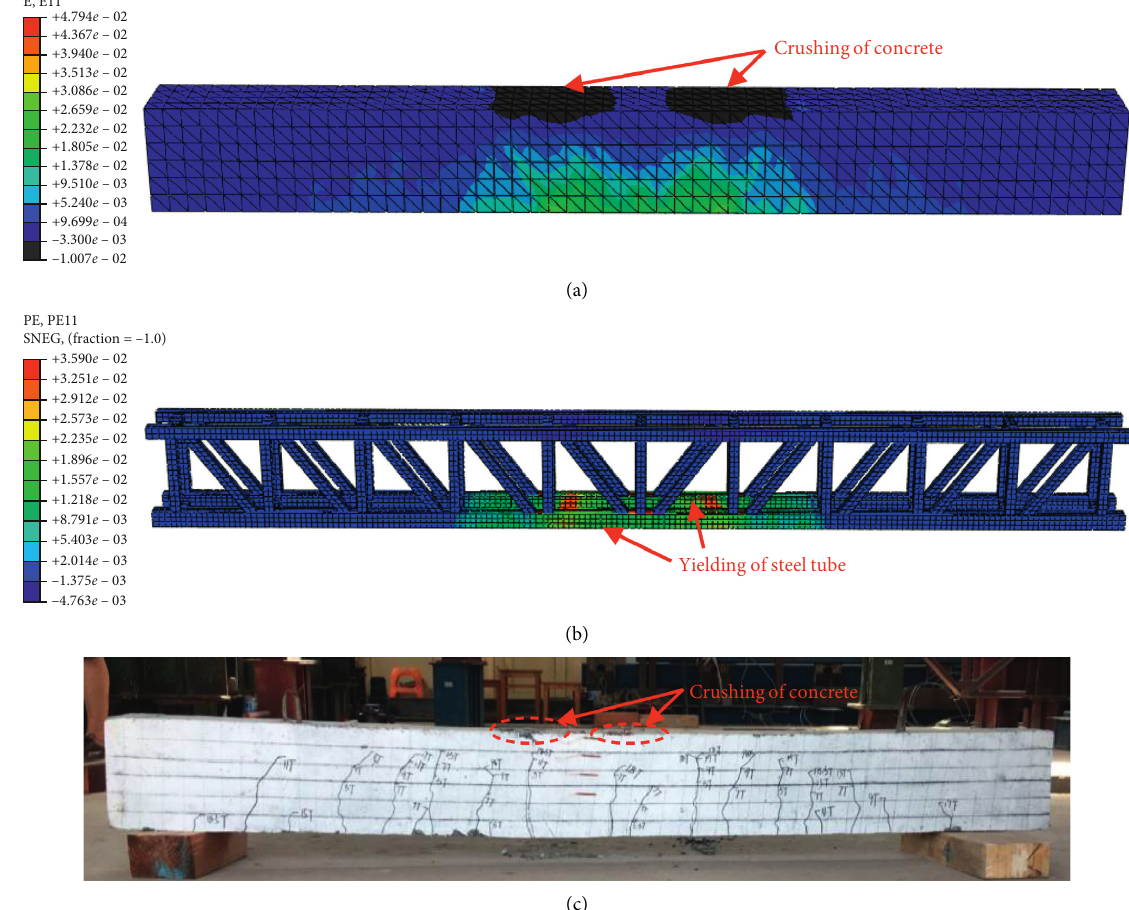
Figure 6: Comparison of failure modes. (a) Crushing of concrete for FEA model. (b) Yielding of steel trusses for FEA model. (c) Failure mode of beam